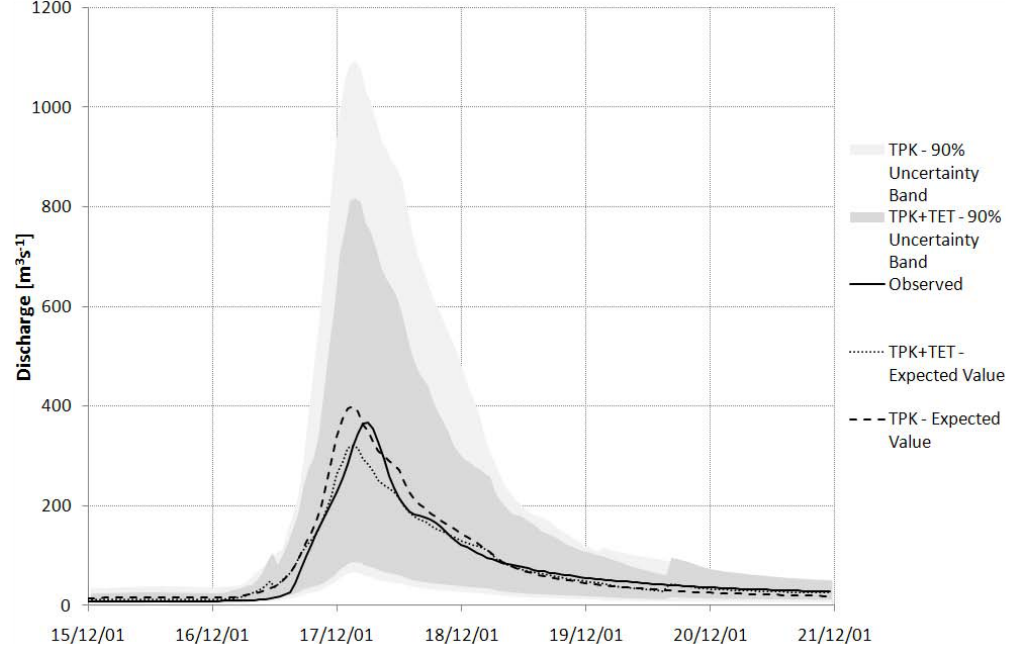
Fig. 13. Comparison between the PU computed with one or two models on a flood event for the calibration period. Observed discharges (black line); expected value conditioned only to the TOPKAPI forecast (dashed line); expected value conditioned to the TOPKAPI and TETIS forecasts (dotted line); 90% uncertainty band conditioned to the TOPKAPI forecast (light grey band); 90% uncertainty band conditioned to the TOPKAPI and TETIS forecasts (grey band).